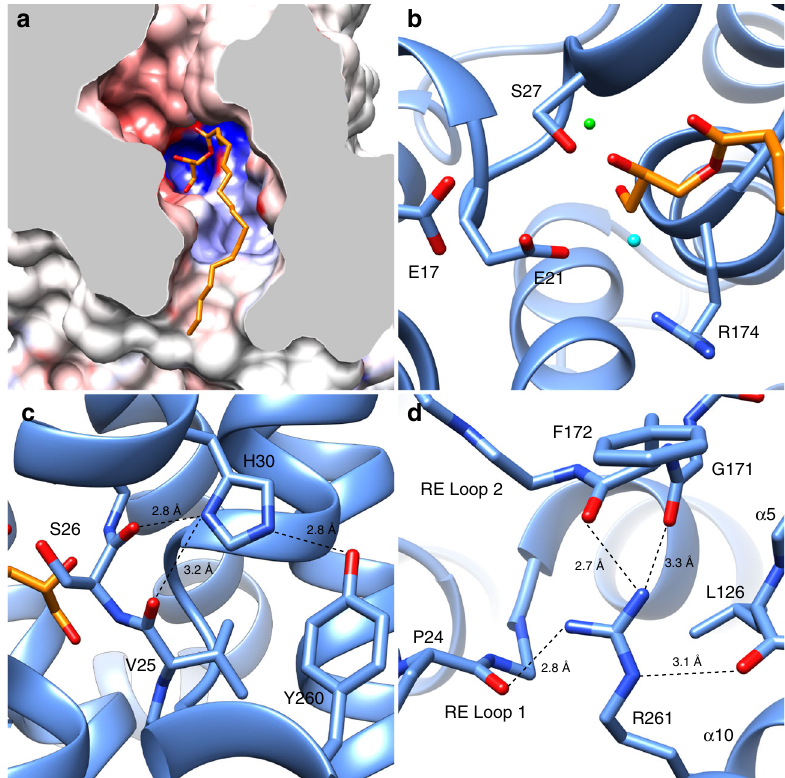
Fig. 2 The Ec UppP substrate-binding pocket. a Clipped view of the Ec UppP substrate-binding pocket from a periplasmic viewpoint showing the electronegative funnel and deep hydrophobic channel leading into the positively charge basin formed by the antiparallel inverted reentrant helices de fi ning the active site. An observed monoolein lipid is shown in stick with the polar headgroup bound in the active site pocket and lipid tail exiting the cleft along the hydrophobic channel. b Magni fi ed view of the Ec UppP active site with key catalytic residues shown in stick. Two modeled active site waters are shown as cyan and green spheres representing the proposed catalytic water and a putative cation-binding site, respectively. c His30 forms structural hydrogen bonds with the backbones amides of Val25 and Ser26, as well as the hydroxyl oxygen of Tyr260. d Arg261 is buried at the membrane midplane (also see Supplementary Fig. 6) and forms a hydrogen-bonding network that links both reentrant loops (RE Loop 1/2) through the backbone amides of Pro24, Gly171, and F172, in addition to α 5 through the backbone amide of